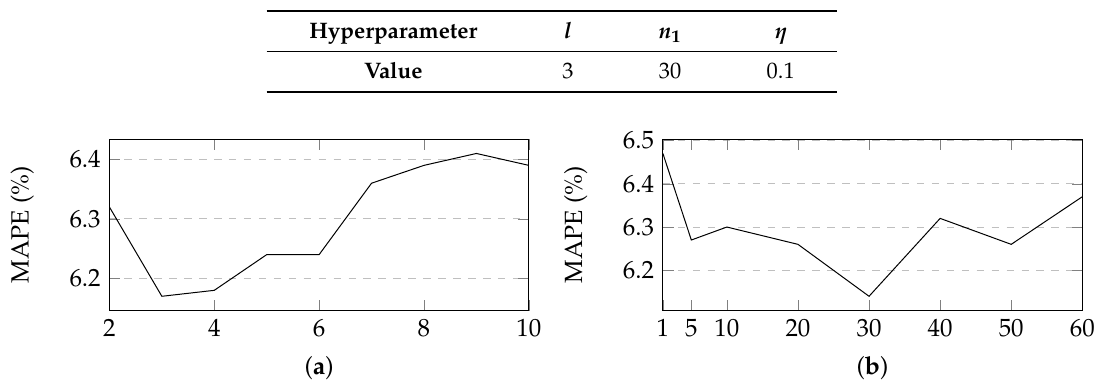
Figure 4. Variety of the MAP with parameters l and n 1 in the proposed method. ( a ) Size of an input sequence. ( b ) Number of the kernels of the convolution